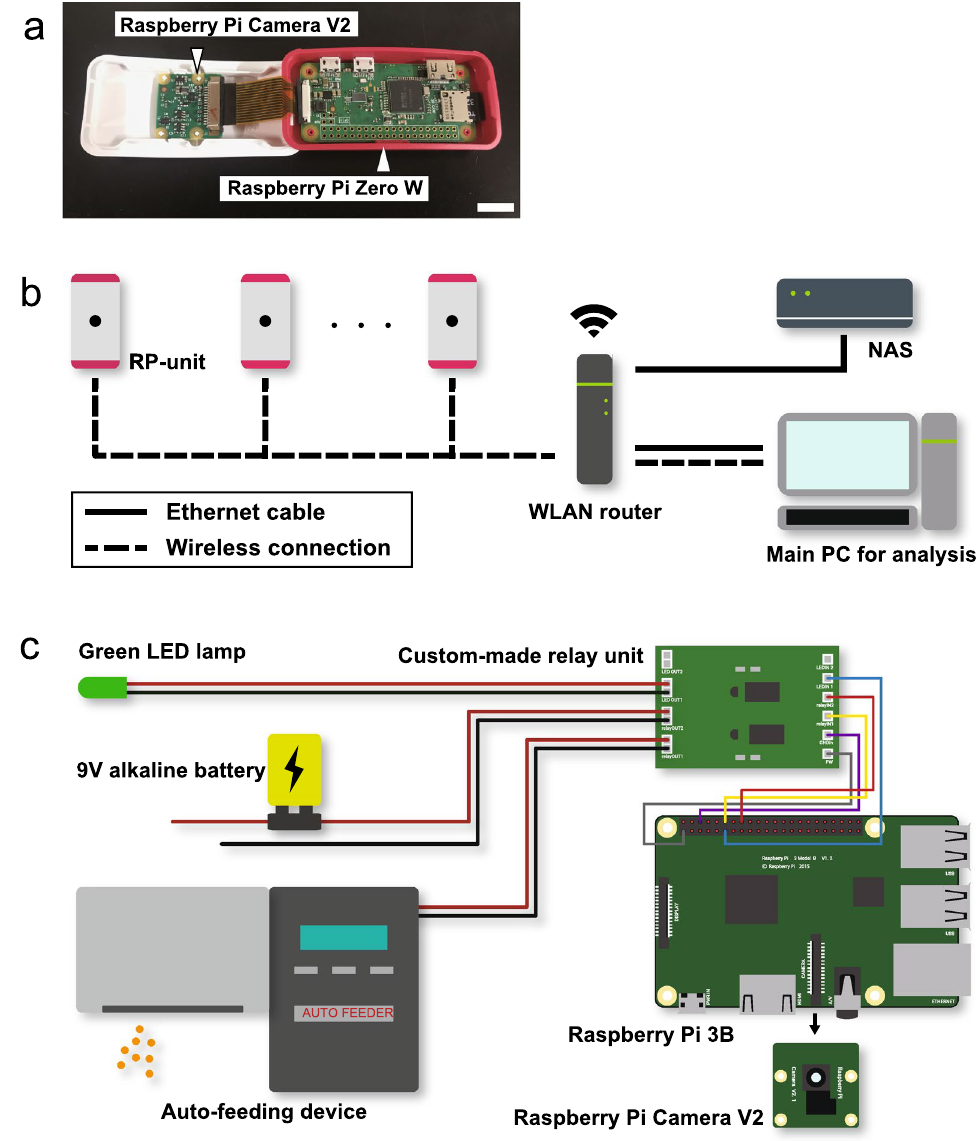
Figure 1. Hardware setup. ( a ) Photograph of RP-unit with their cases open. Raspberry Pi Camera V2 is connected to Raspberry Pi Zero W through the flat flexible cable. Scale bar indicates 1 cm. ( b ) Connection diagram of automated behavioral recording system. 16 RP-units are wirelessly connected to WLAN, while NAS is connected to WLAN router through Ethernet cable. We accessed and operated RP-units through SSH remote login by using a Windows PC, which is represented as “Main PC for analysis” on this figure. ( c ) Schematic diagram of another unit for automated switching of LED lamp, auto-feeding device, and the electric circuit including 9 V alkaline battery. These external devices are connected a custom-made relay unit that is connected to GPIO pins on Raspberry Pi 3B. Raspberry Pi Camera V2 is also connected to Raspberry Pi 3B for video- recording. Raspberry Pi 3B can be replaced to Raspberry Pi Zero